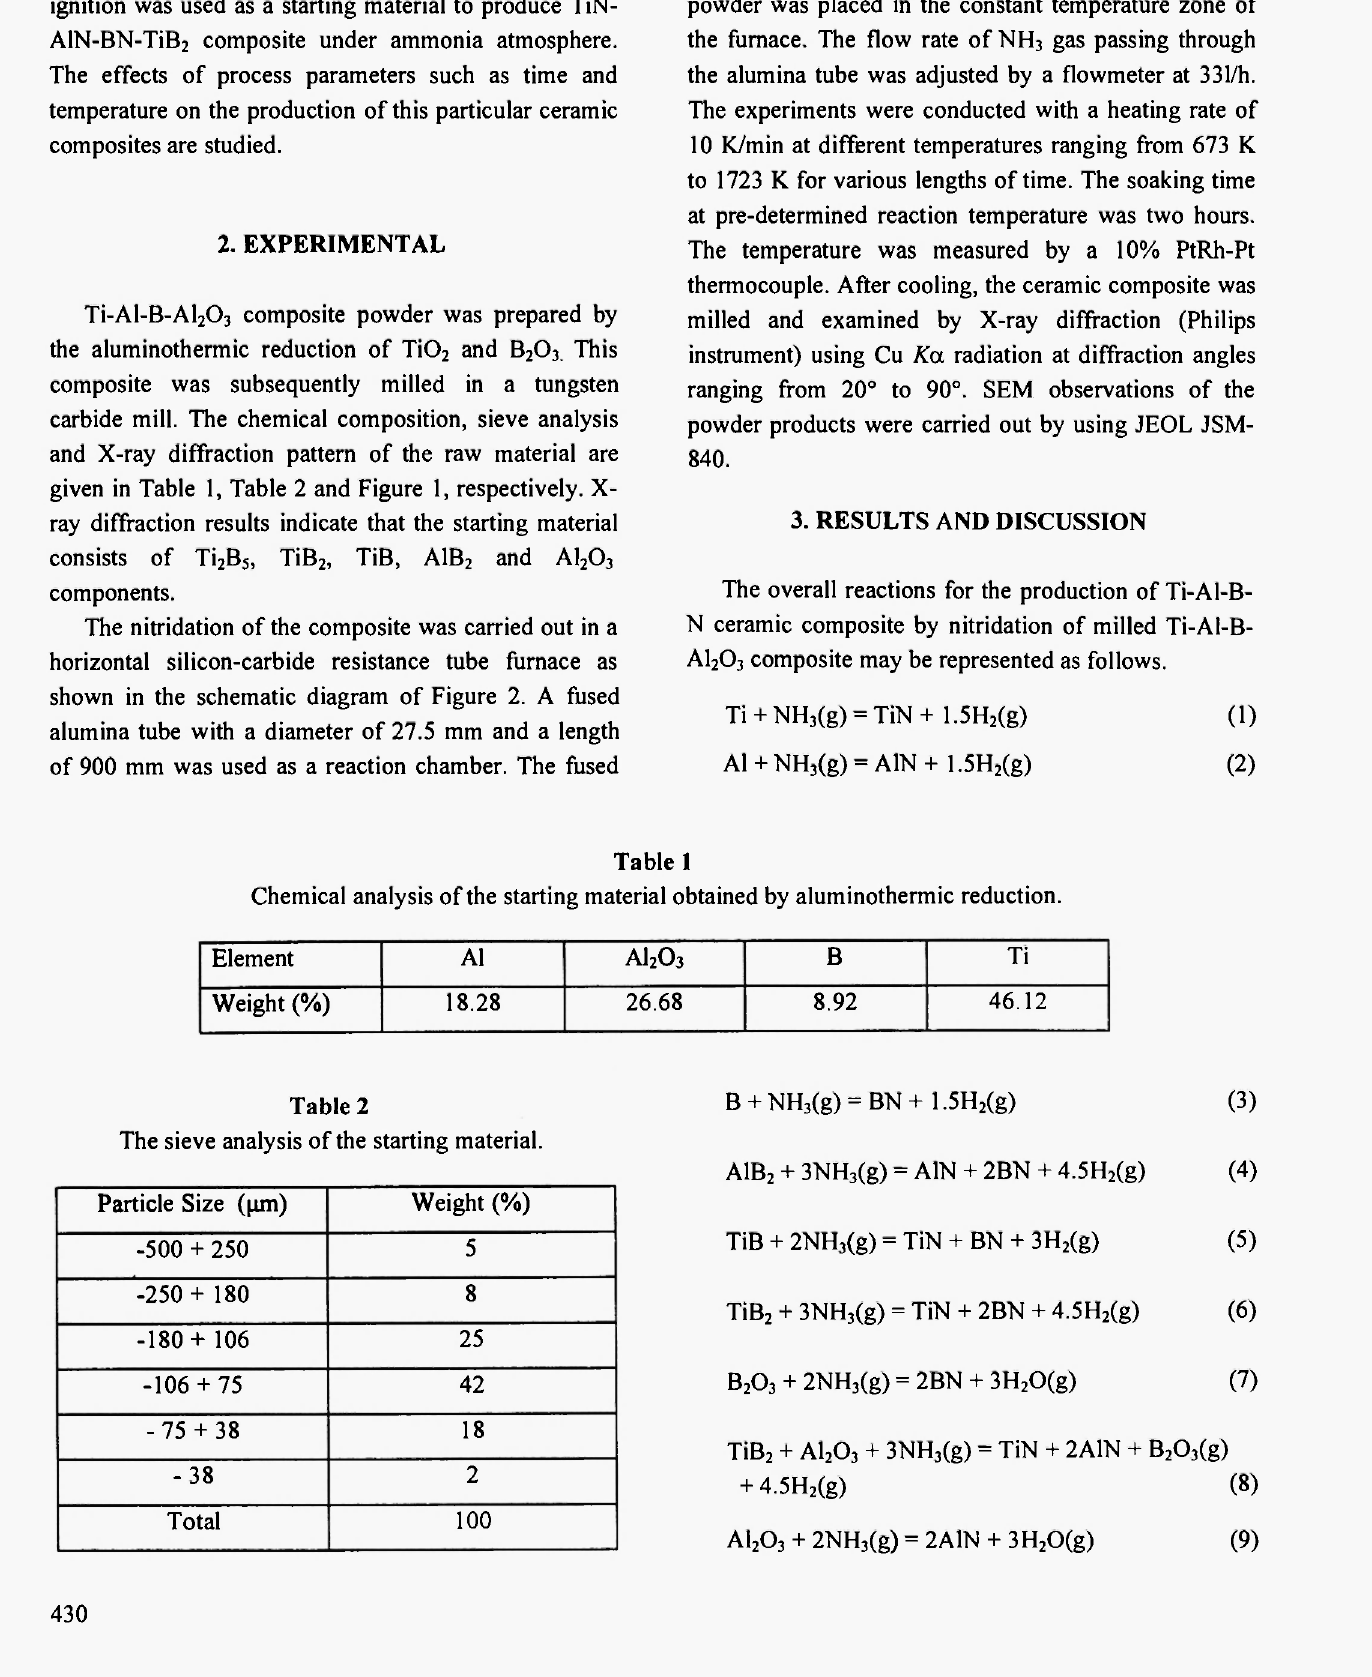
The sieve analysis of the starting